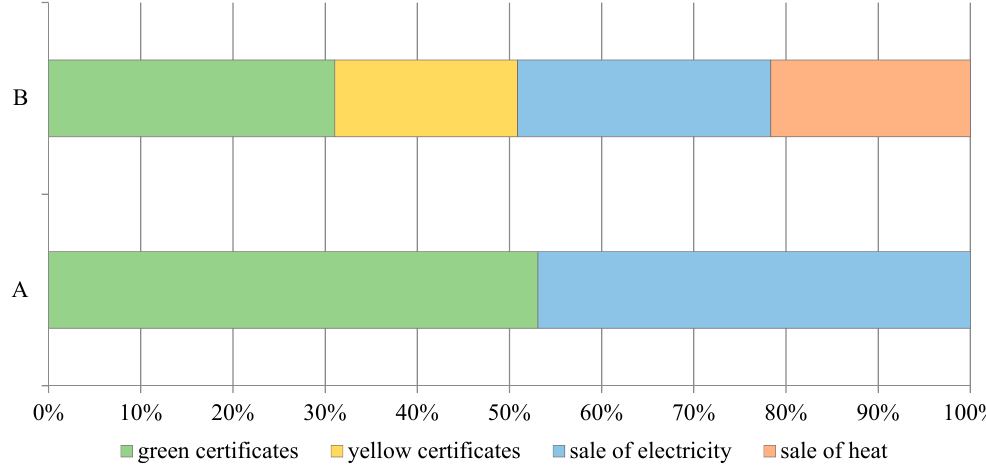
Figure 3. Structure of revenues in the analysed agricultural biogas plants.